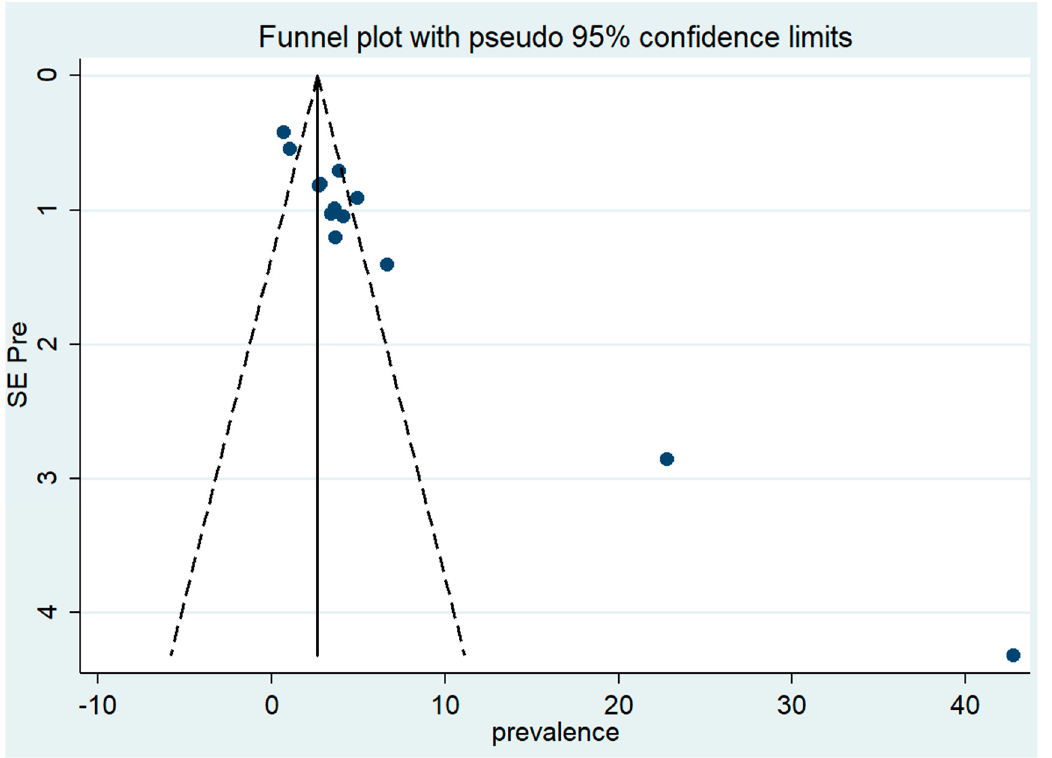
Figure 7. Funnel plot: visual inspection of publication bias for meta-analysis of Pneumocystis pneu- monia.